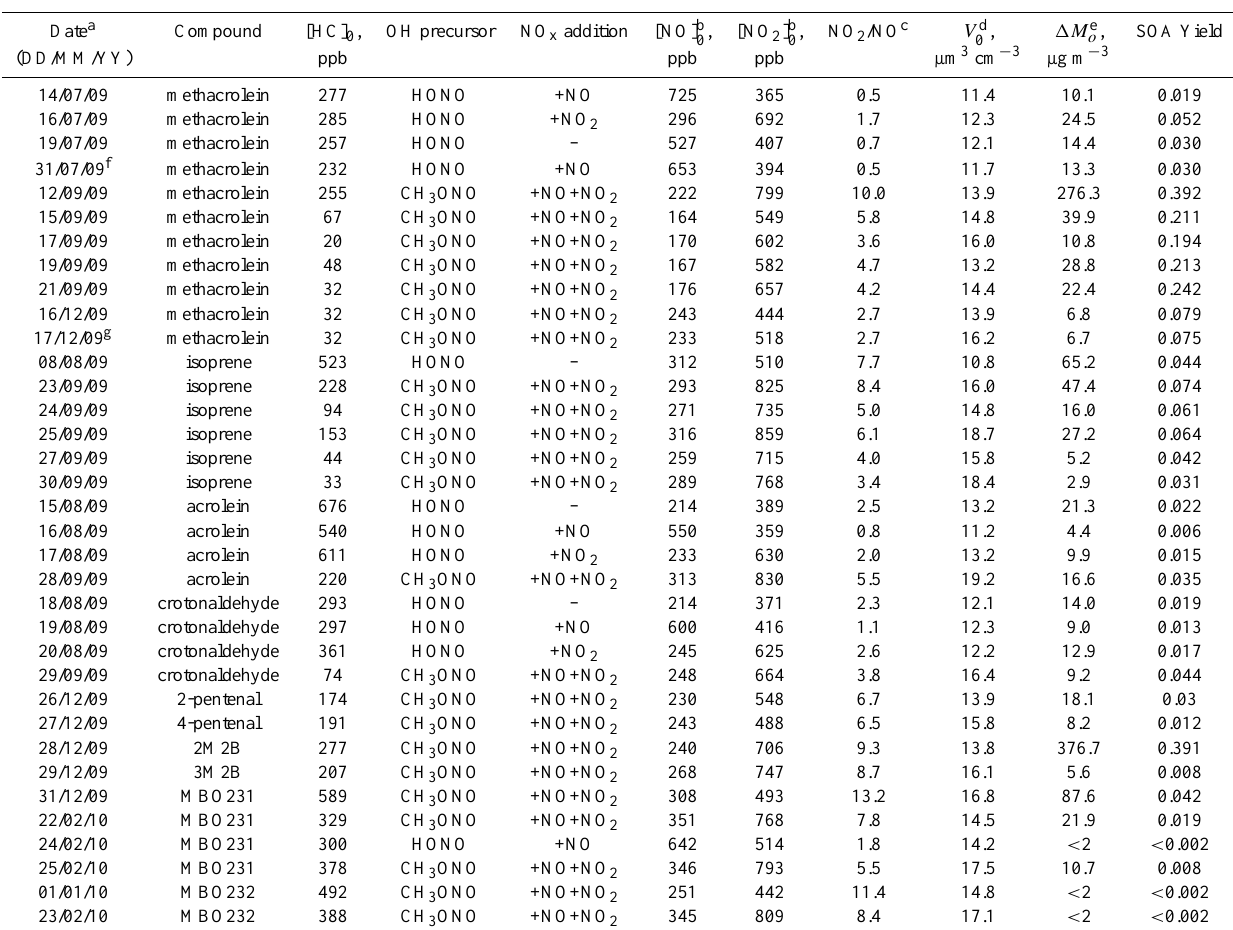
Table 2. Experimental conditions and